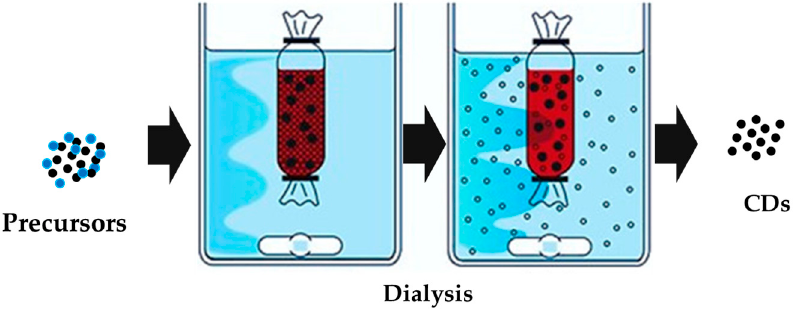
Figure 1. Dialysis purification of CDs for the isolation adapted from Lo Bello et al. [25] under Creative Commons Attribution License 4.0 (CC BY).